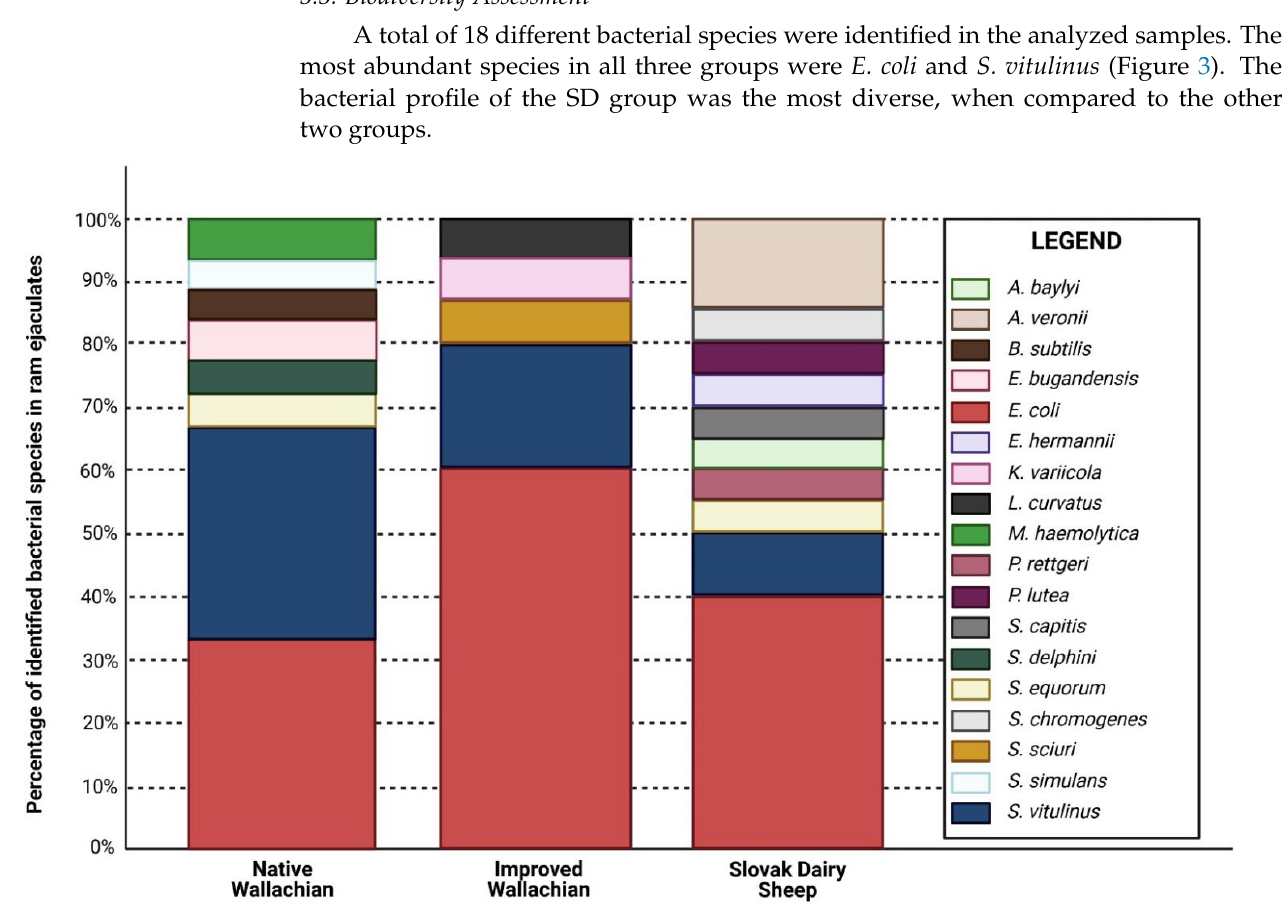
Figure 3. Heatmap of bacterial species identified in the ejaculates of individual ram breeds.